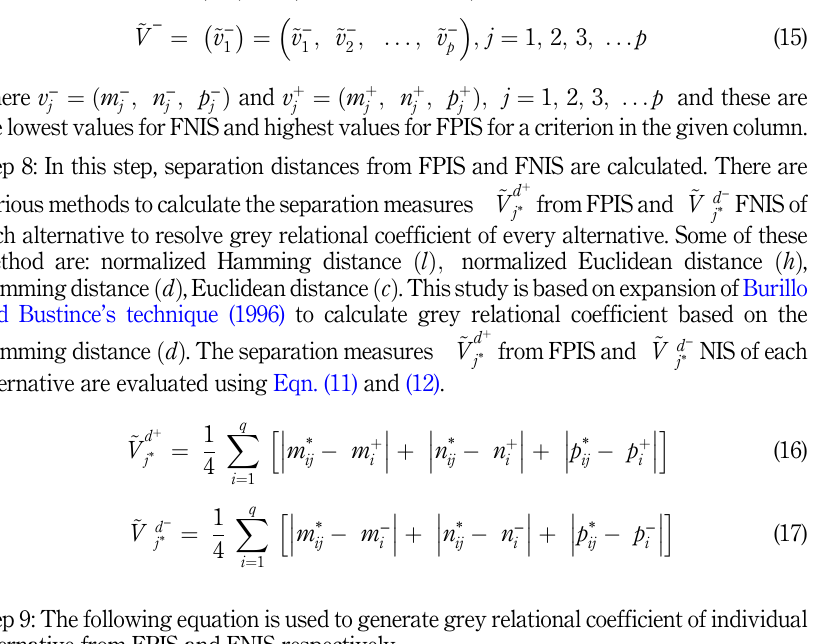
~ V using Eqn (14) and (15)